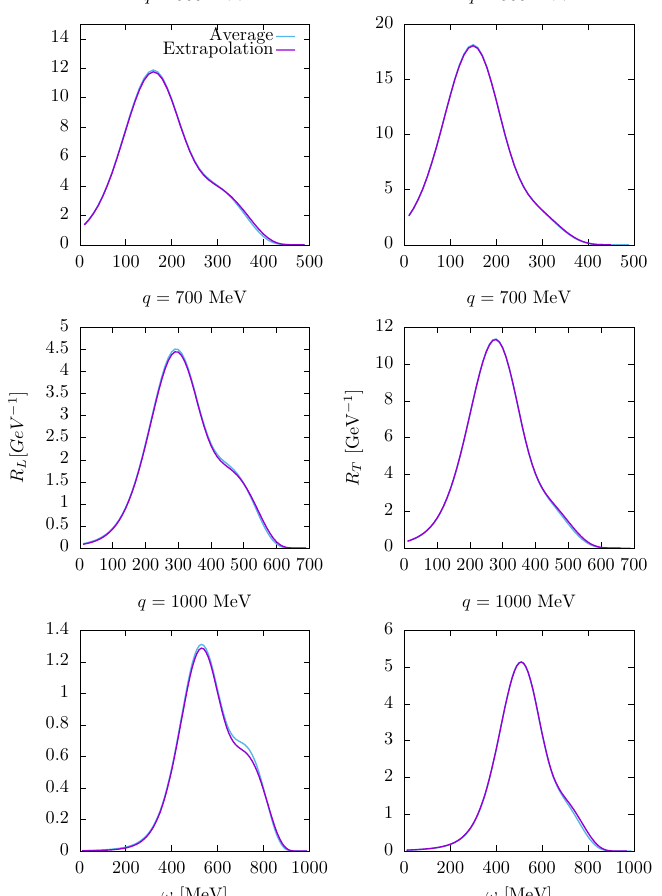
Figure 7. Longitudinal and transverse response functions in the SuSAM* model using the averaged and extrapolated single-nucleon